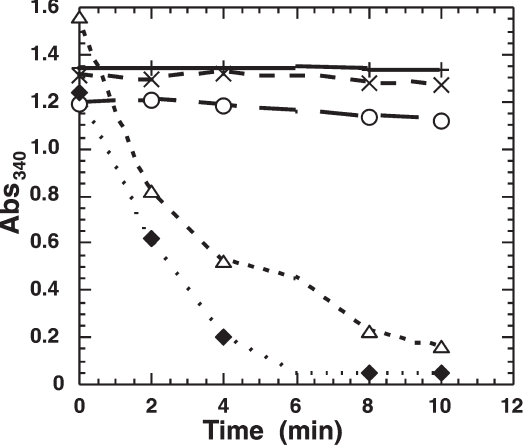
Figure7. Cytoplasmictriosephosphateisomeraseis presentin sphero- plasts. The activity of triosephosphateisomerasewas measured with a coupled assay as described in Materials and methods. Oxidation of NADH was monitored over time with A. fulgidus whole- cell extract ( (cid:2) ), sonicated protease-treated cells ( (cid:3) ), reaction mix (with whole-cell extract) minus glycerol-3-phosphate dehydrogenase ( (cid:4) ), reaction mix minus glyceraldehyde-3-phosphate (×) and NADH in re- action buffer (+).